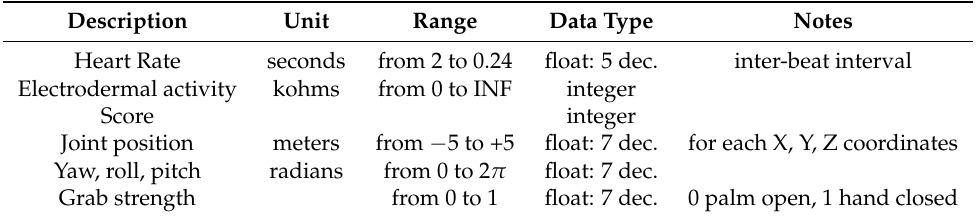
Table 1. Details about the motion and biophysical data collected during the activity: unit of measurement, typical range of values and data type in the